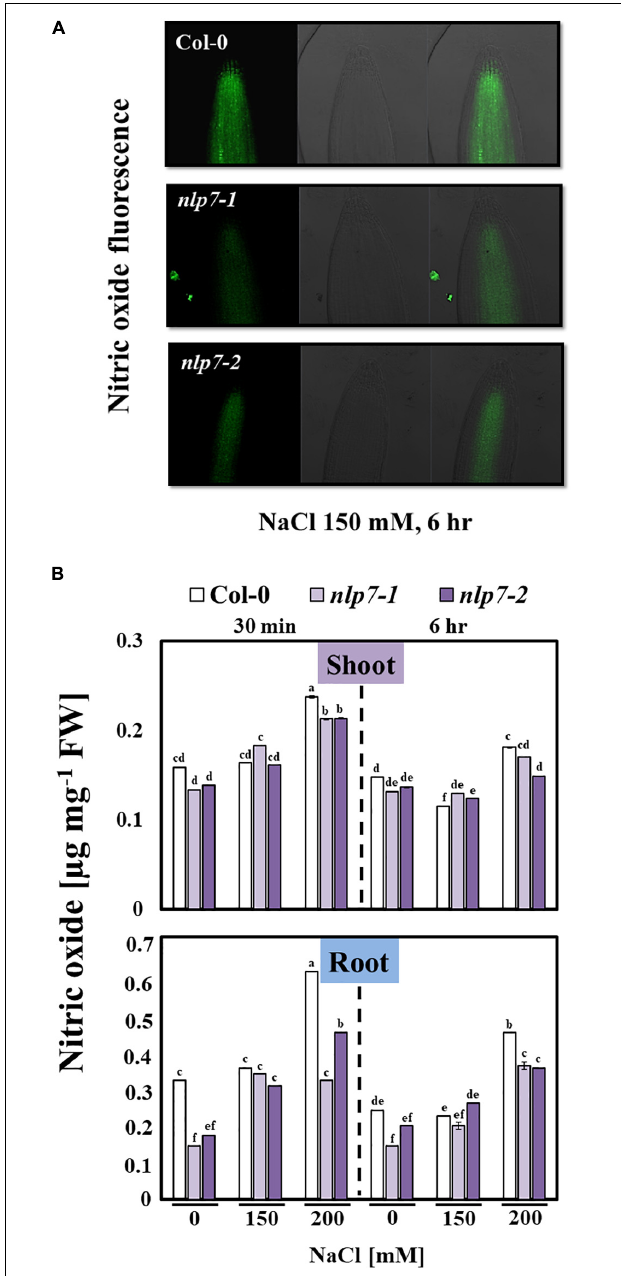
FIGURE 5 | The nlp7 mutants showed reduced nitric oxide (NO) content under salt stress. (A) The NO accumulation in the root tips of Col-0 and nlp7 seedlings following exposure to 150 mM NaCl. The Col-0, nlp7-1 , and nlp7- 2 seedlings were germinated and grown on a nitrogen-free half-strength MS medium containing 5 mM KNO 3 for 9 days and then treated with 200 mM NaCl for 6 h. The roots of the test seedlings were incubated with 5 µ M of DAF-FM DA in 20 mM HEPES-NaOH (pH 7.5) for 30 min in the dark, and the NO-associated fluorescence was visualized using a laser confocal scanning microscope (LSM 700; Zeiss, Jena, Germany). The excitation wavelength was 488 nm, and emission wavelength was 515–565 nm. Images on the left were obtained under green fluorescence, and the ones in the middle were obtained under bright-field microscopy; the images of green fluorescence and (Continued)